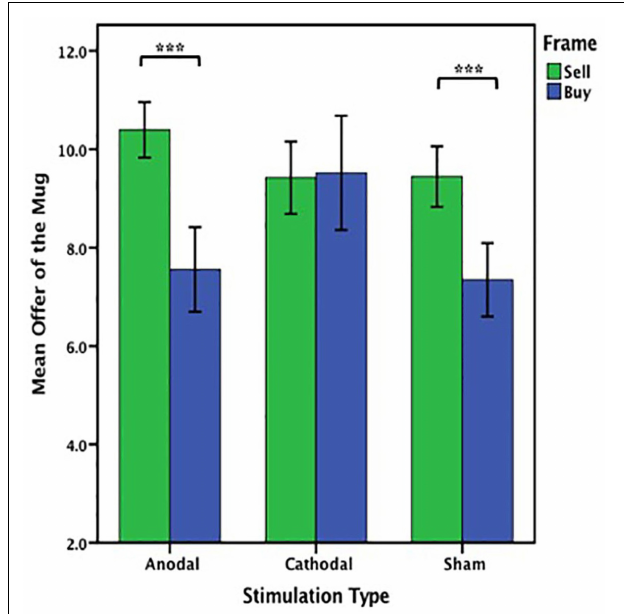
FIGURE 5 | Data of offer of the mug (Experiment 1). The mean offer of the mug across three stimulations in each frame. Error bars indicate 95% confidence intervals. Asterisks indicate statistically significant difference between WTA and WTP.